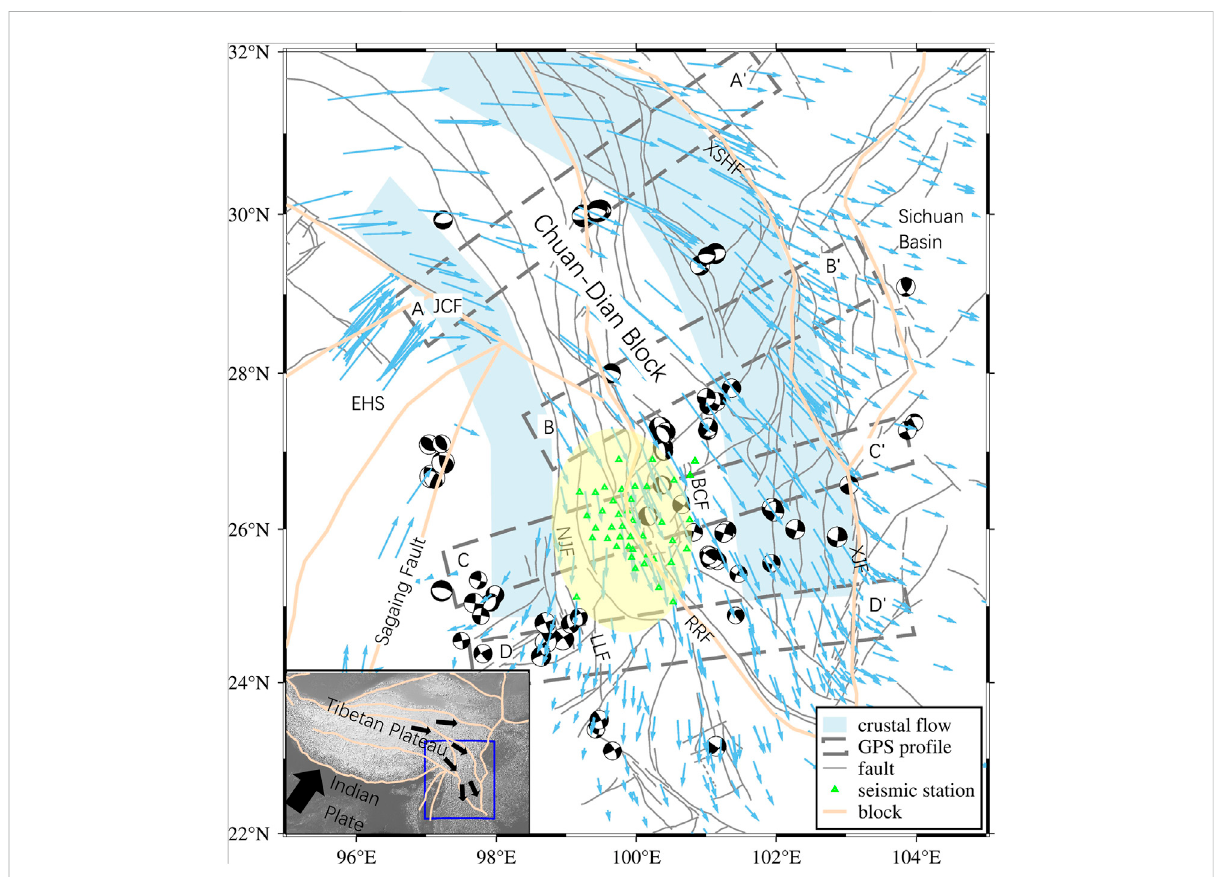
FIGURE 1 Topographic map of south-eastern Tibet. Focal mechanism (1976 – 2010): from the global CMT catalogue; blue arrows: GPS velocity fi eld relative to Eurasian Plate (Wang and Shen, 2020); Light blue polygons represent crustal fl ow channels delineated using magnetotelluric data (Bai et al., 2010). The yellow area represents the extensional zone based on focal mechanism and GPS analysis; Black arrows show regional crustal motions.NJF=NujiangFault;LLF=LonglingFault;BCF=BinchuanFault;RRF=Red-RiverFault;XSHF=XianshuiheFault;XJF=XiaojiangFault; JCF = Jiali – Chayu Fault; and EHS = eastern Himalayan